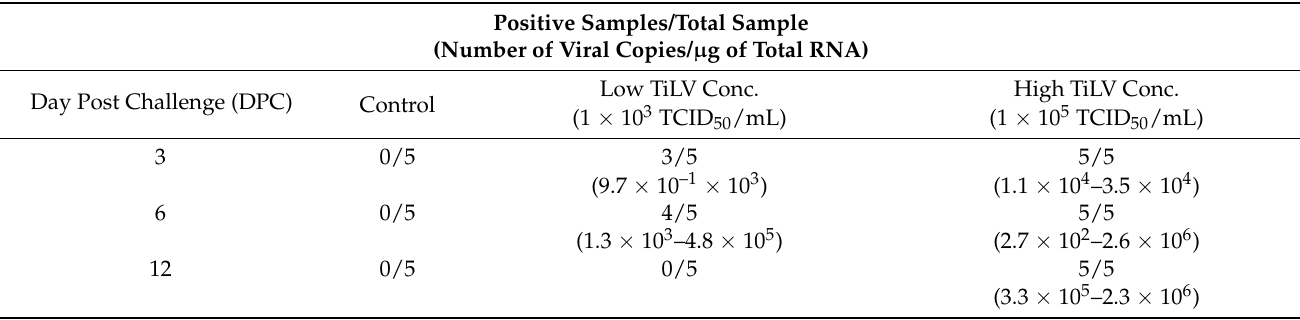
Table 1. Persistence of TiLV genomic RNA in spleen of challenged Mozambique tilapia. Positive Samples/Total Sample (Number of Viral Copies/ µ g of Total